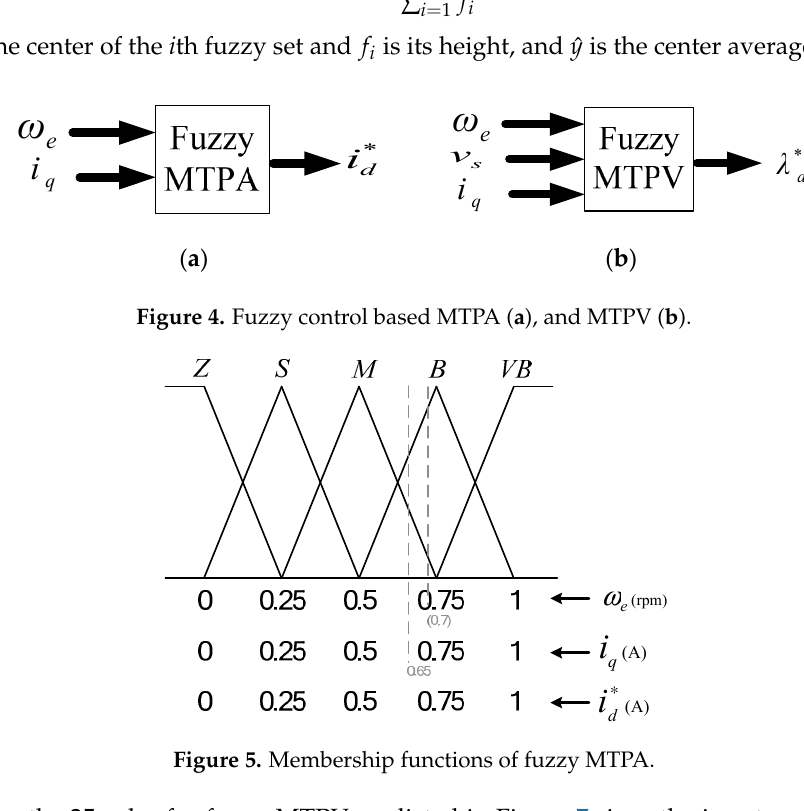
Figure 5. Membership functions of fuzzy MTPA.